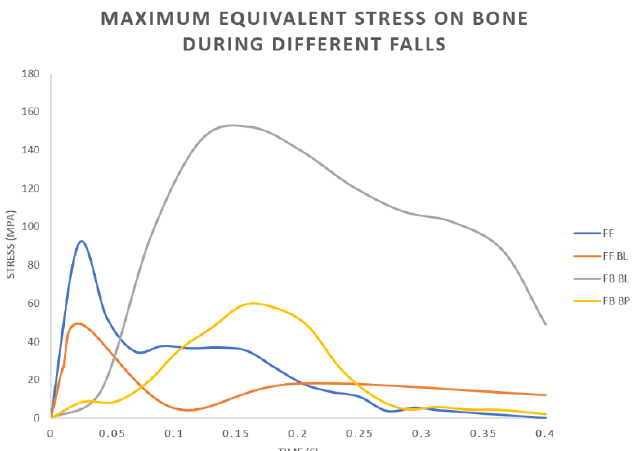
Figure 9. OPL prosthesis: Plots of the maximum values of the equivalent stress on the bone during different fall scenarios: Fall Forward (FF), Fall Forward with Balance Loss (FF BL), Fall Backwards with Balance Loss (FB BL), Fall Backwards “By Push” (FB BP).